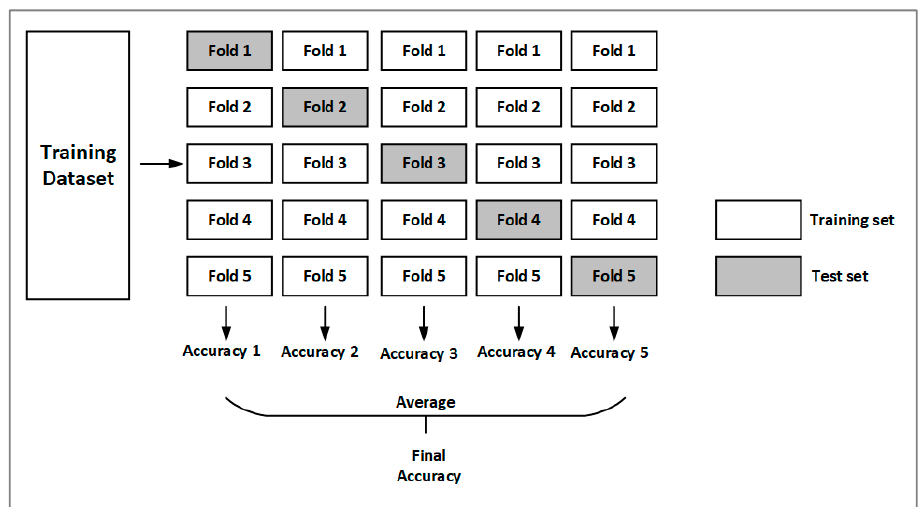
Figure 4. The processes of 5-fold cross-validation.